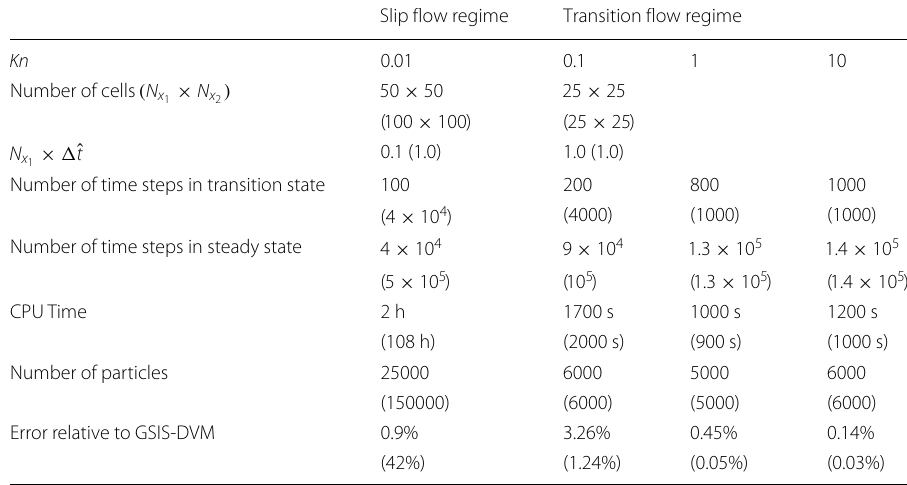
Table 2 Comparison between GSIS-LVDSMC and LVDSMC (values in parentheses) algorithms for the 2D Poiseuille flow in square channel Slip flow regime Transition flow